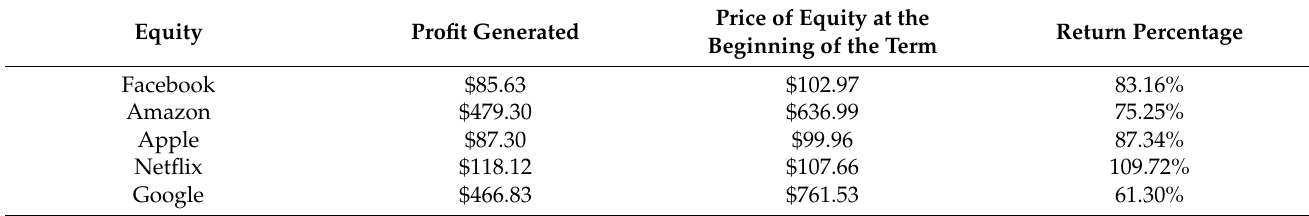
Table 7. Profits generated when backtesting on test data for the FAANG